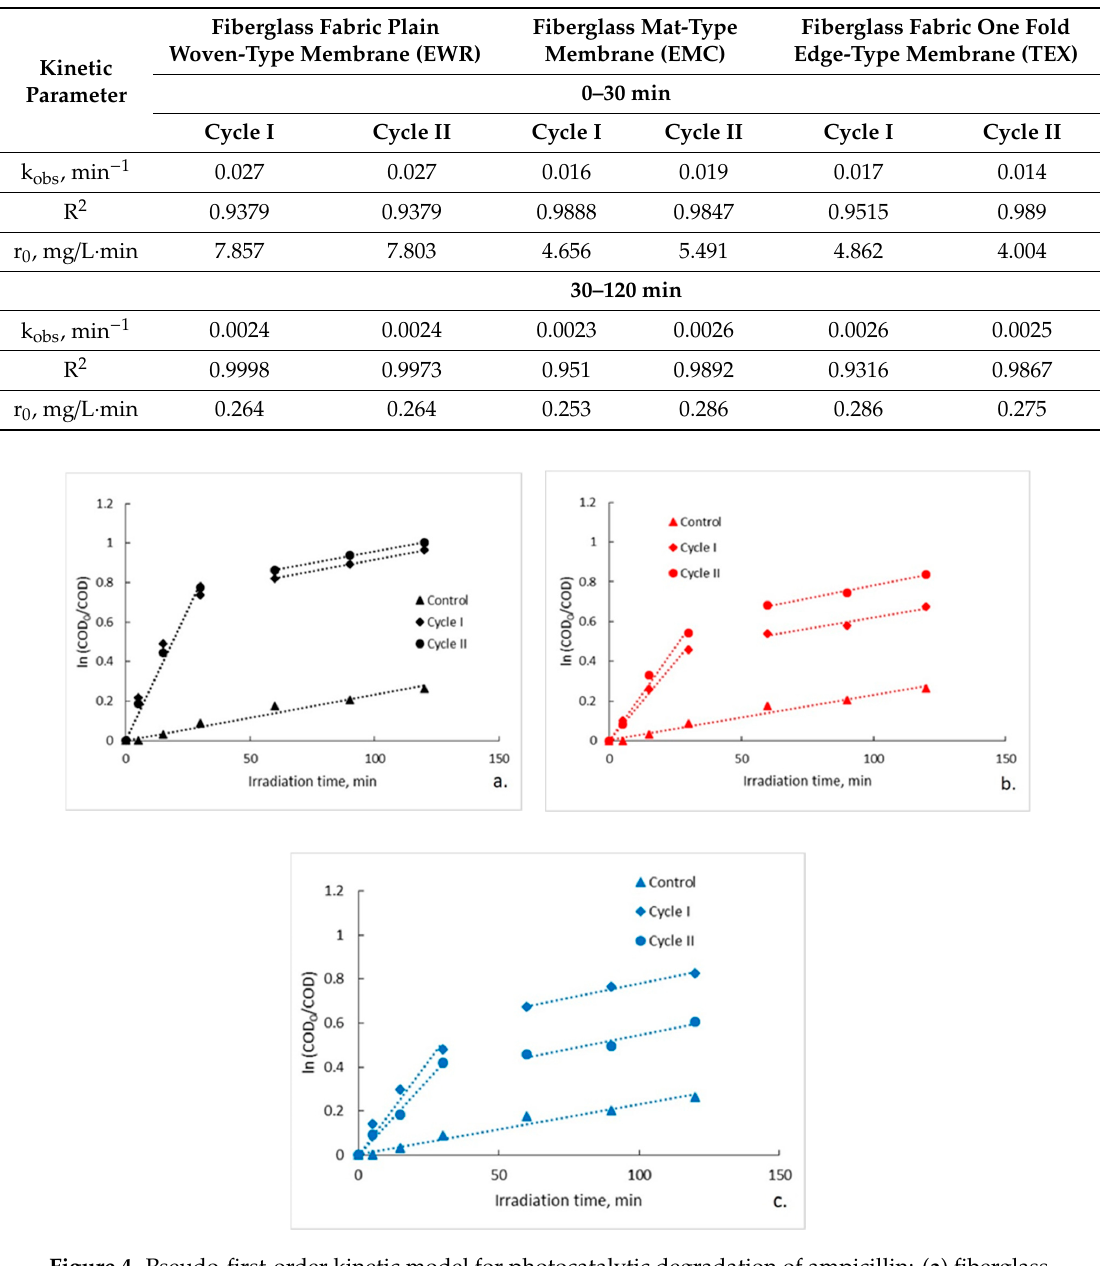
Figure 4. Pseudo-first-order kinetic model for photocatalytic degradation of ampicillin: ( a ) fiberglass fabric plain woven-type membrane (EWR); ( b ) fiberglass mat-type membrane (EMC); ( c ) fiberglass fabric one fold edge-type membrane (TEX).